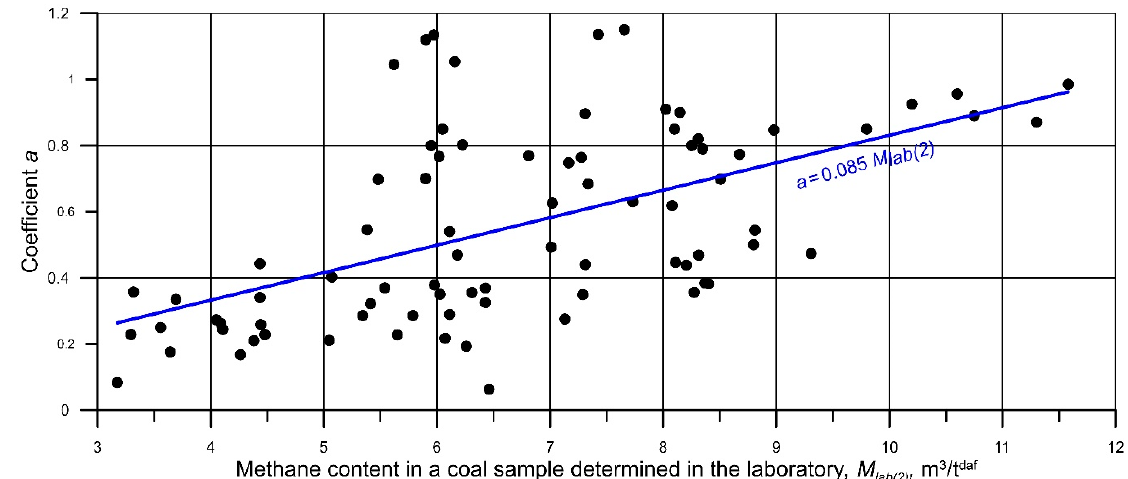
Figure 4. Relationship between coefficient a and methane content in coal samples in second minute of desorption M lab ( 2 ) .